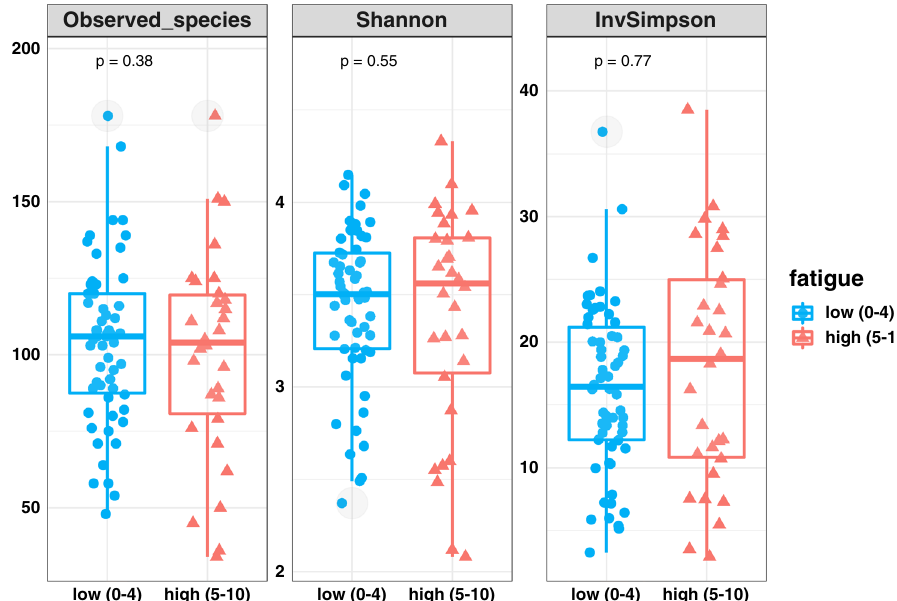
Figure 1. Box plots showing differences in alpha diversity between low- and high-fatigue patients. Each blue dot represents one patient in the low-fatigue group; each red triangle represents one patient in the high-fatigue group. The box-and-whisker plot describes the distribution of data points, including minimum, maximum, median, first quantile and third quantile. Grey shaded circles denote